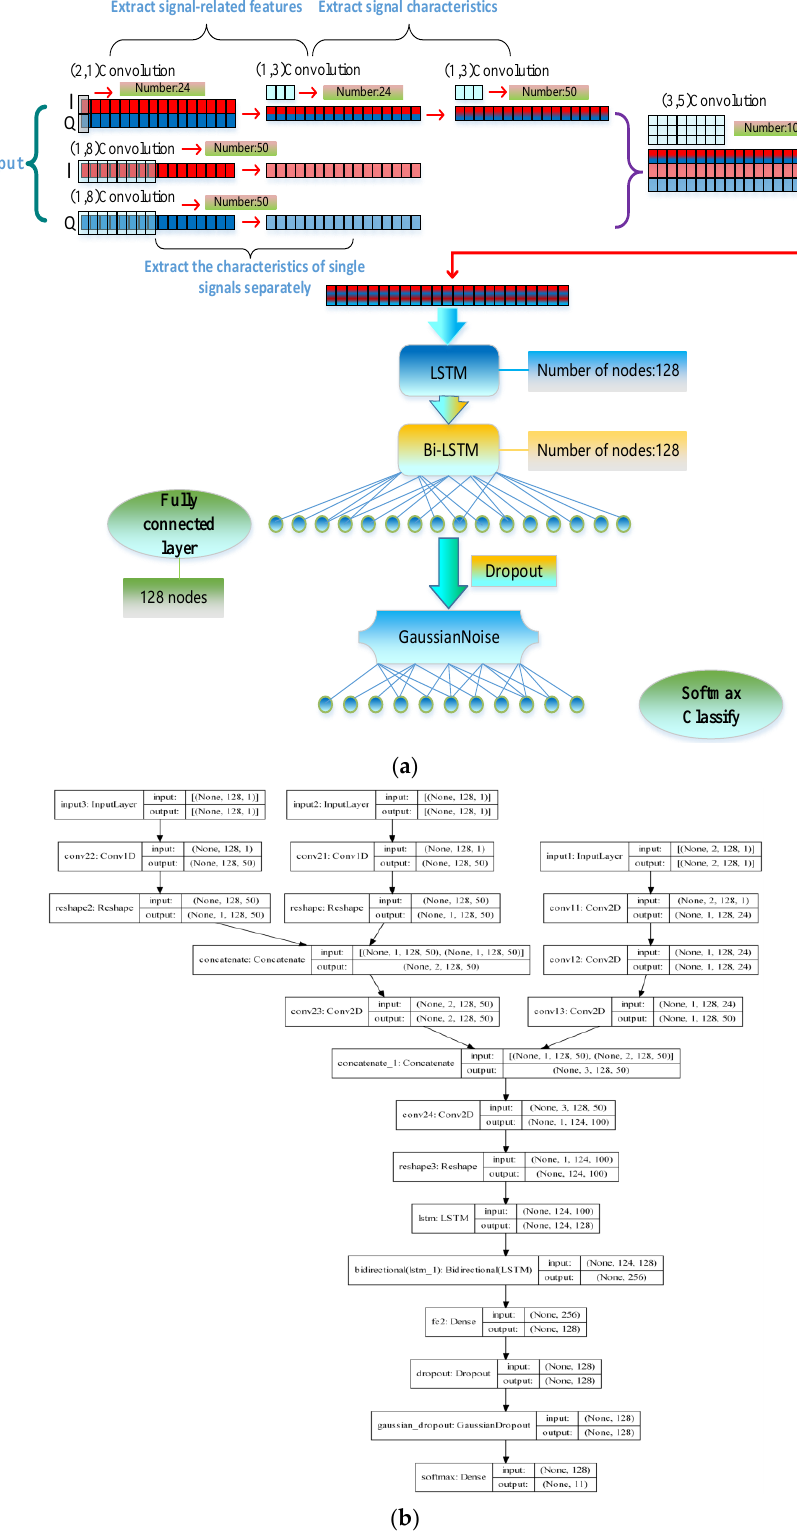
Figure 4. IQGMCL structure. ( a ) Intuitive model; ( b ) Plot_model visualization.